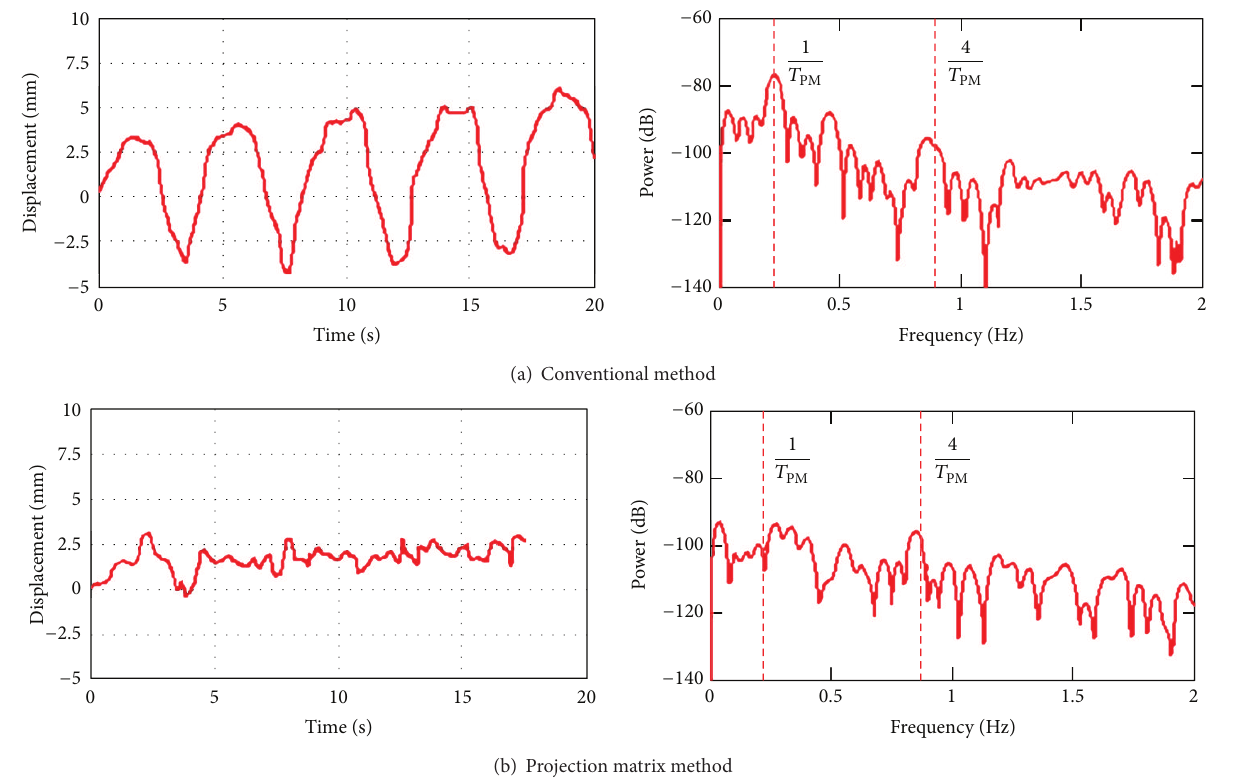
Figure 6: Signal processing results at the distance of